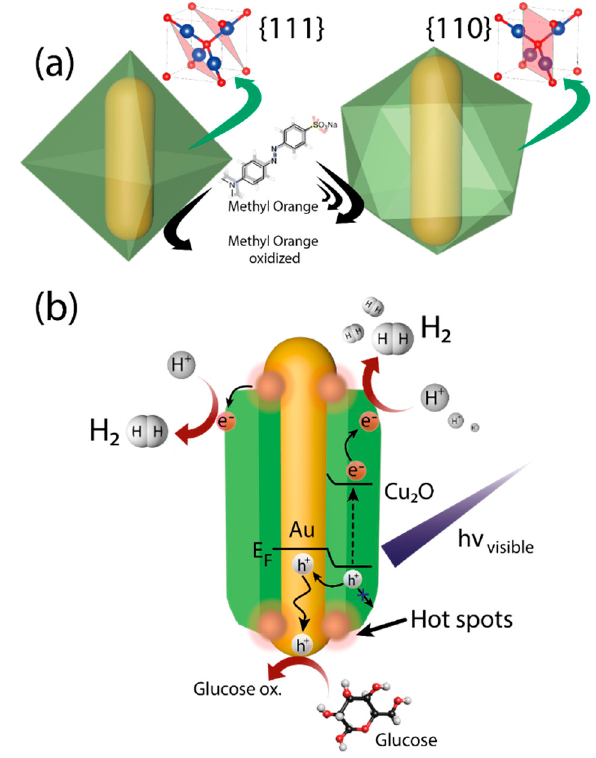
Figure 7. ( a ) Face dependent selectivity of Au@Cu 2 O photoredox catalysis in MO degradation (adapted from [107]) ( b ) Selective Cu 2 O deposition for partially/completely coated AuNR (adapted from [32]).